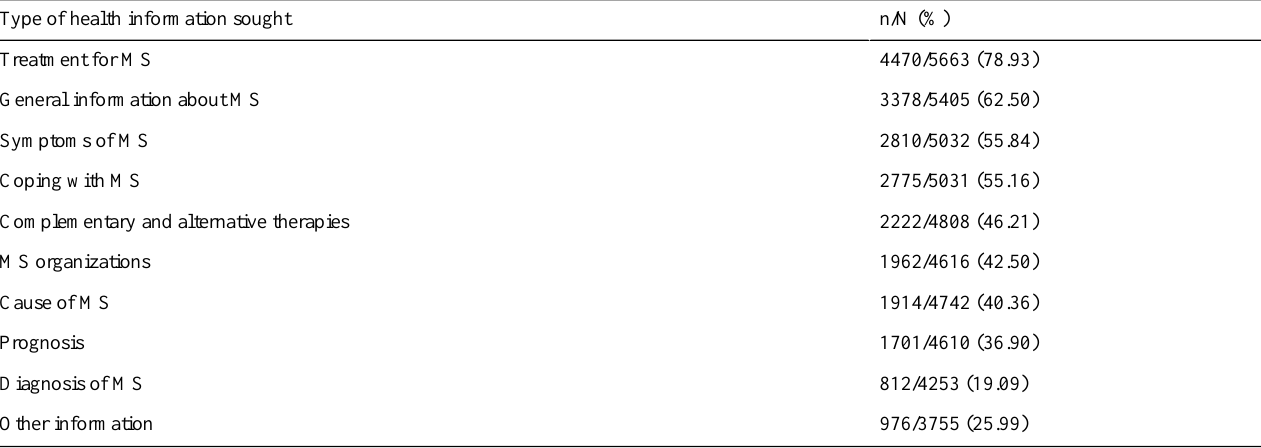
Table 4. Type of health information sought about MS at the time of the most recent